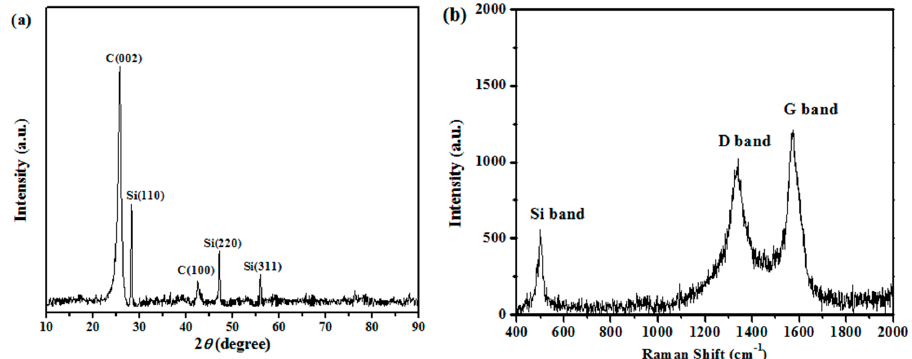
Figure 6. XRD pattern ( a ) and Raman pattern ( b ) of the silicon-carbon nanocomposite prepared by DC magnetoelectric plasma under optimal conditions.